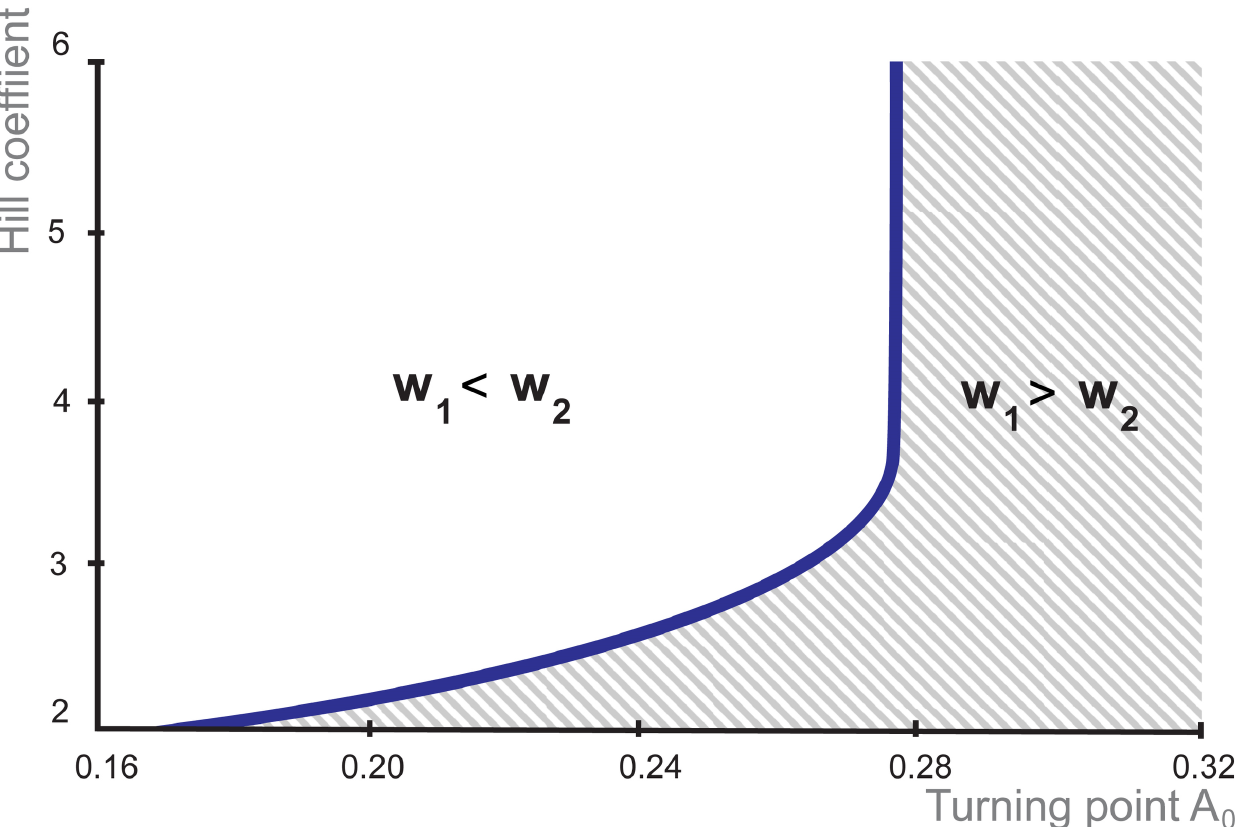
Fig 4. Dependence of the Hill coefficient value on the value of OS activating signal at which transition from differentiation to pluripotency occurs. The horizontal and vertical axes represent the values of parameters A 0 and h , respectively. The curve distinguishes between pluripotency and differentiation states.